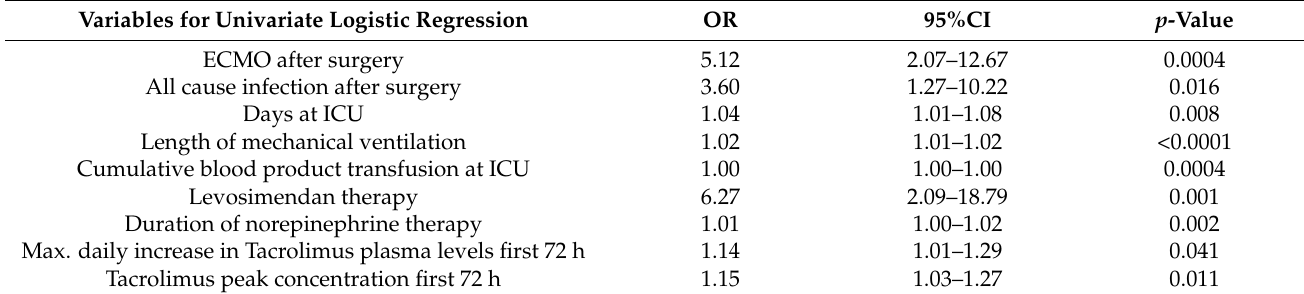
Table 2. Univariate logistic regression for significant variables associated with acute kidney injury requiring renal replace- ment therapy after heart transplantation.